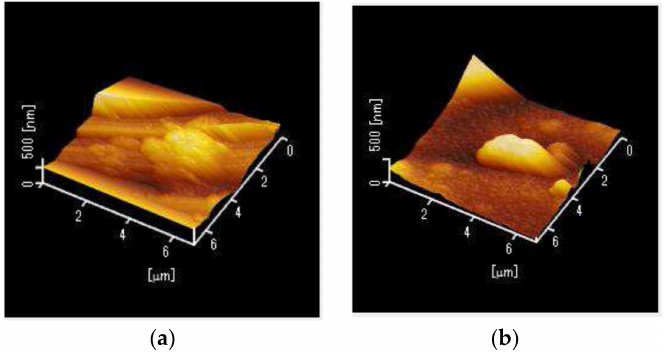
Figure 3. Inner surface of SUS tubing observed by atomic force microscopy (AFM) after applying two and four layers of base coating. The RMS roughness are 119 nm for two coats and 83 nm for four coats. ( a ) two times re-coating; ( b ) four times re-coating.